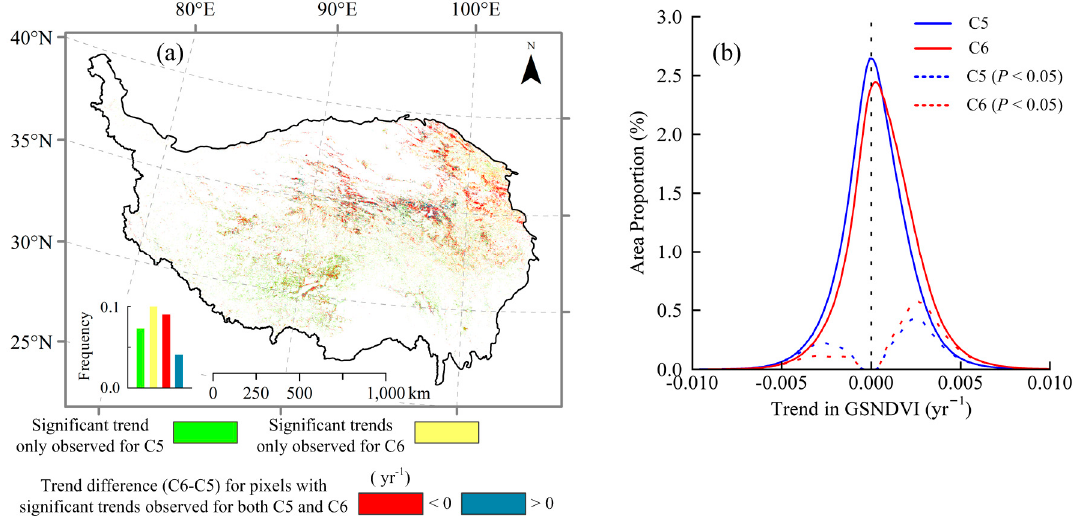
Figure 3. ( a ) Comparison of trends in growing season Normalized Difference Vegetation Index between C5 (GSNDVI C5 ) and C6 (GSNDVI C6 ) during 2001–2015; and, ( b ) The histograms of trends in GSNDVI C5 and GSNDVI C6 during 2001–2015.